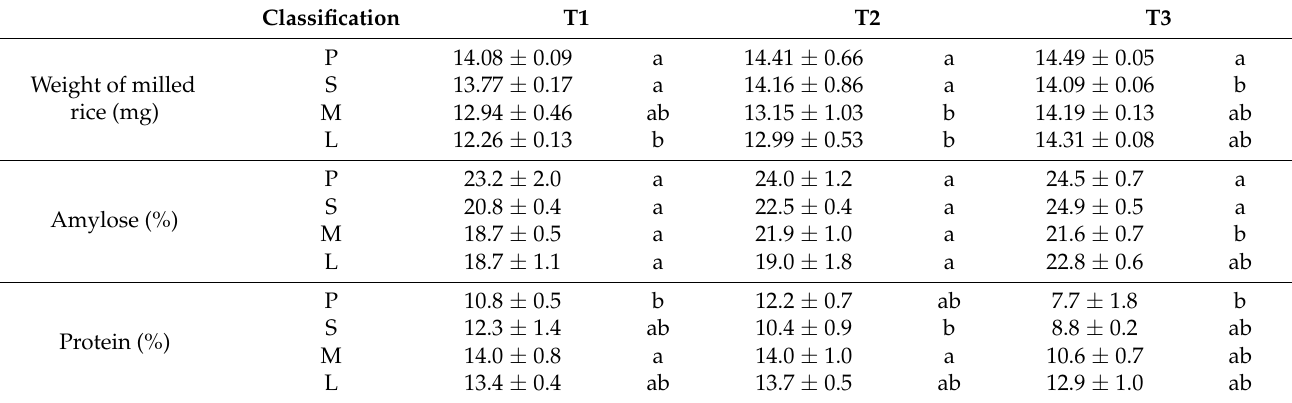
Table 3. Changes in milled rice weight, amylose, and protein for each treatment group and chalkiness classification.